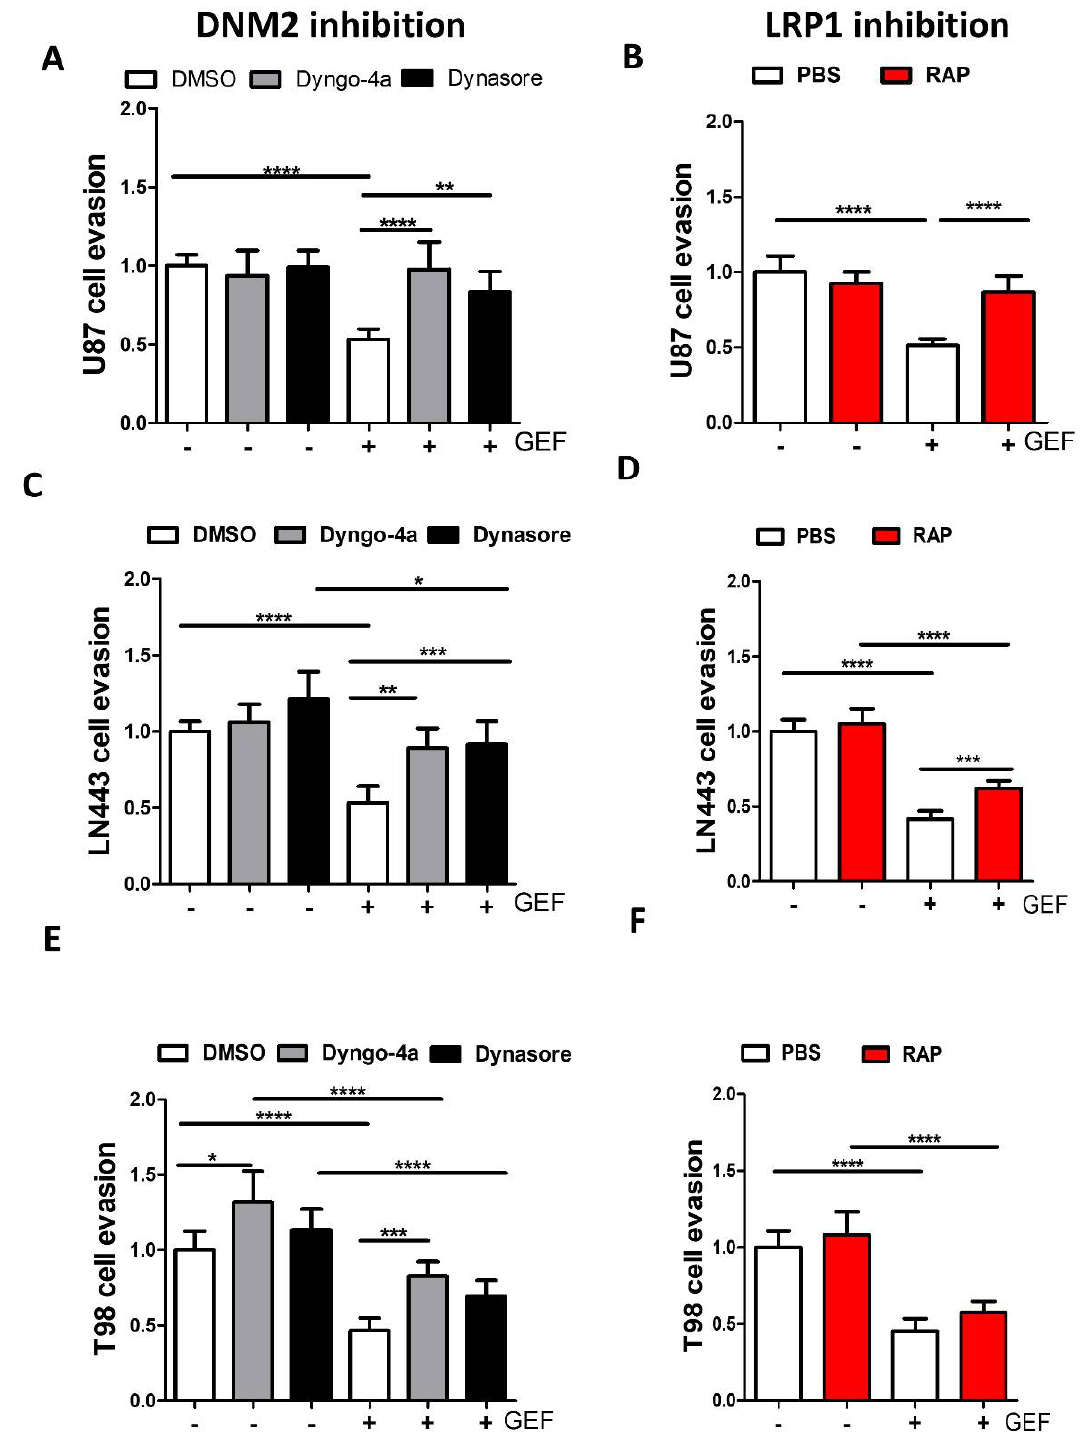
Figure 6. GME inhibition decreases gefitinib efficacy on cell evasion. ( A ) U87 two-day-old spheroids were plated onto collagen-I-coated (10 µg·mL −1 ) plastic dishes. Spheroids were treated with DNM2 GTPase activity inhibitors (10 µM of